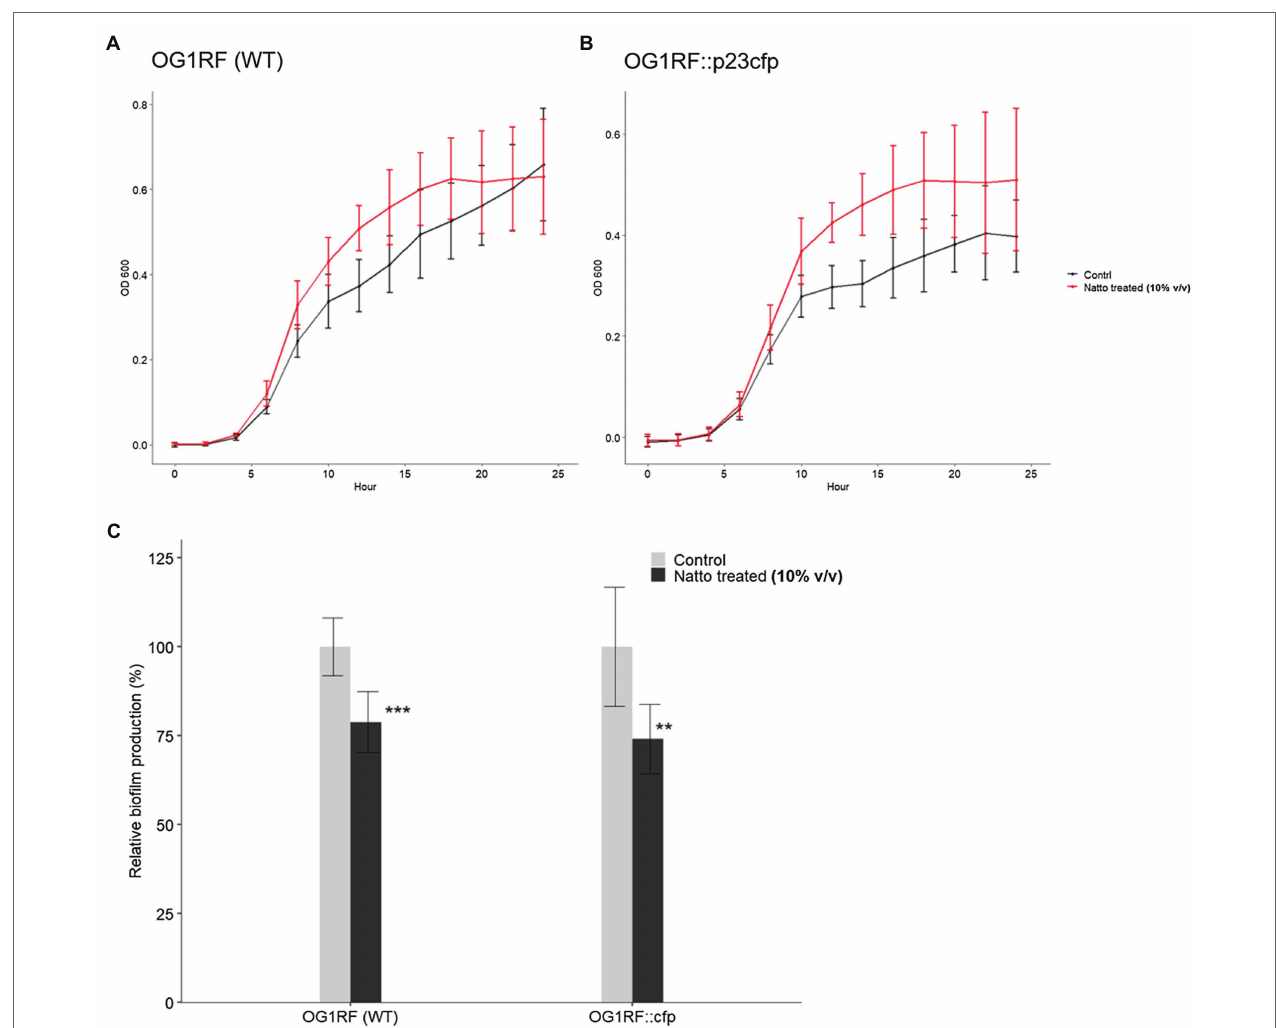
FIGURE 3 | Bacillus subtilis natto supernatant interferes with E. faecalis biofilm production but not growth. (A,B) Growth curves of E. faecalis OG1RF WT and OG1RF::p23cfp in the absence or presence of B. subtilis natto supernatant (10% v/v) for 24 h. In (A) and (B) , the Y axis shows the OD 600 values of the bacterial cultures at different time points. The data are presented as the means ± SDs ( n = 8). (C) Biofilm production in the absence or presence of B. subtilis natto supernatant (10% v/v) for 24 h. Biofilm production is expressed as an index of the biomass stained with safranin (OD 450 value) normalized to the cell growth (OD 600 value at 24 h). Relative biofilm production (%) was calculated by further normalizing the biofilm index values of the treated group to those of the negative control group to which no B. subtilis natto supernatant was added. The data are presented as the means ± SDs ( n = 8). ** p < 0.01 and *** p < 0.001 compared with each negative control group (Student’s t